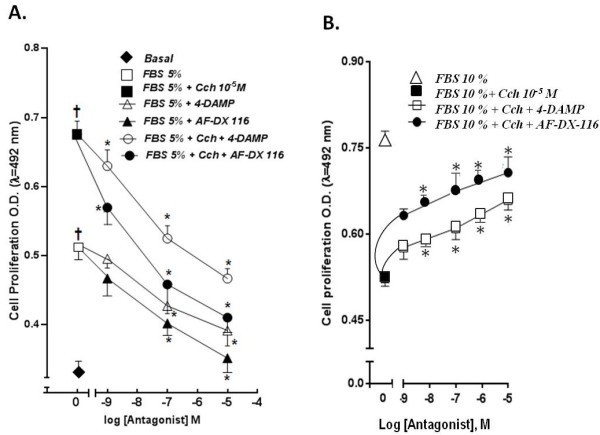
Effect of selective muscarinic antagonists AF-DX-116 (M2AChR) and 4-DAMP (M3AChR) on ASMC proliferation at 5 and 10% FBS. A. Effect of increasing concentration of AF-DX-116 and 4-DAMP on the synergistic effect induced by Cch in presence of 5% FBS. ASMC (1× 103 cells/well) were cultured in 96 wells plates for 72 hrs. Cell proliferation was determined using a colorimetric method (MTS-PMS), measuring O.D at λ = 492 nm. (n = 5, for triplicate). The synergistic proliferation responses in the presence of 5% FBS and Cch (1 × 10-3 M) plus 5% FBS against basal condition were significant different (┼) p < 0.05. The muscarinic antagonists inhibitory responses were significant against the “0” Cch condition (*) p <0.05. The estimated Log IC50 ± SE were 4-DAMP + FBS = −7.34 ± 0.21; 4-DAMP + FBS + Cch = −7.38 ± 0.42; AFDX-116 + FBS = −7.26 ± 0.51 and AFDX-116 + FBS + Cch = −8.99 ± 0.45. B.- Effect of increasing concentrations of AF-DX-116 and 4-DAMP on the anti-proliferative effect induced by Cch (1x10-5 M), in presence of 10% FBS. ASMC (1 × 103 cells/well) were cultured in 96 wells plates for 72 hrs. Cell proliferation was determined using a colorimetric method (MTS-PMS), measuring O.D at λ = 492 nm. (n = 5, for triplicate). The muscarinic antagonists stimulatory proliferative responses were significant (*) p < 0.05 against the anti-proliferative Cch (1x10-5 M). The estimated Log IC50 ± SE were 4-DAMP = −7.11 ± 0.71 and AFDX- = −9.40 ± 0.37.